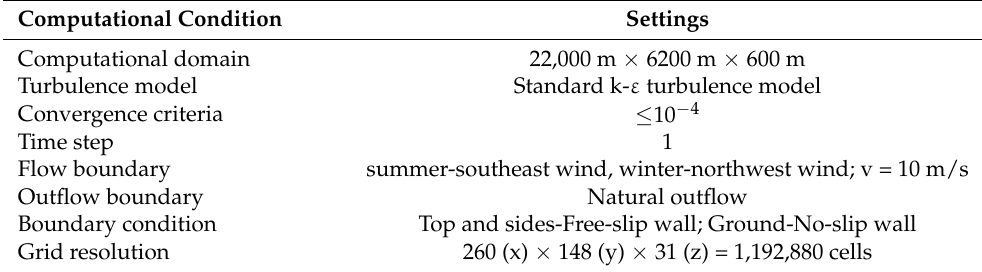
Figure 11. Southeast and northwest wind simulation ( a ) Southeast wind simulation, ( b ) Northwest wind simulation. Table 4. The numerical settings for CFD